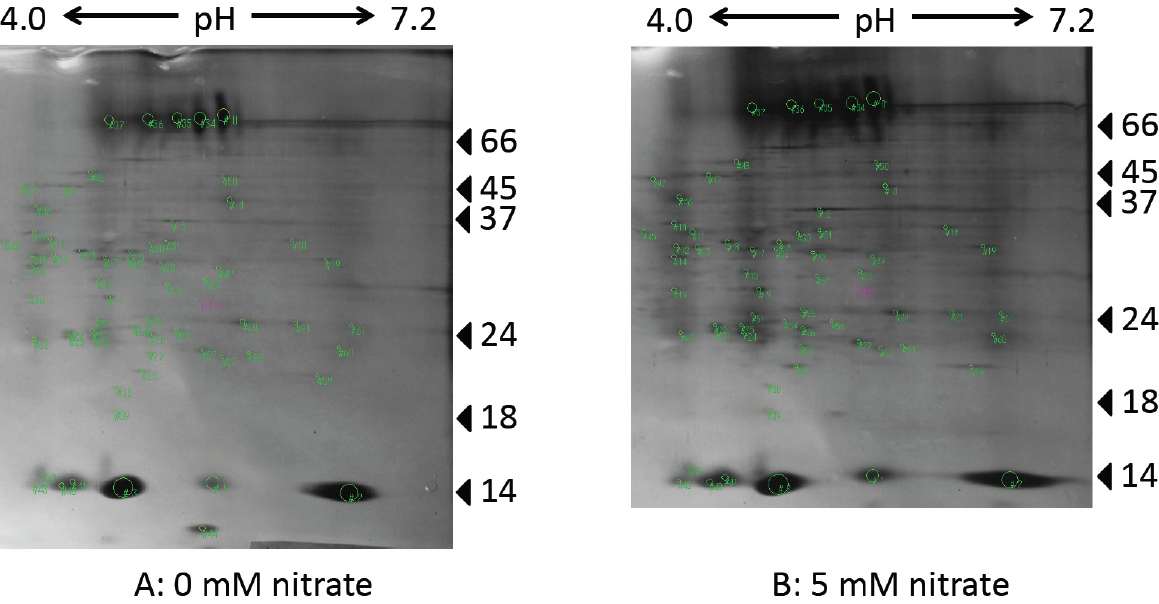
Figure 4. 2D-PAGE of soybean nodules with the 0 and 5 mM nitrate treatments. ( A ) Plant cultivated with 0 mM nitrate; ( B ) Plant cultivated with 5 mM